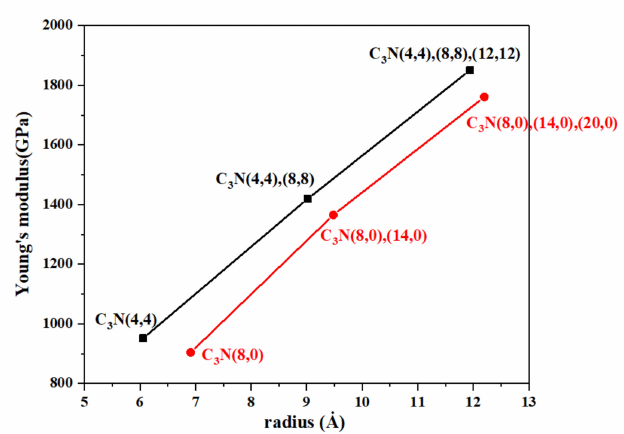
Figure 9. Young’s modulus as a function of nanotube radius for di ff erent types of single-, double-, and triple-walled chiral C 3